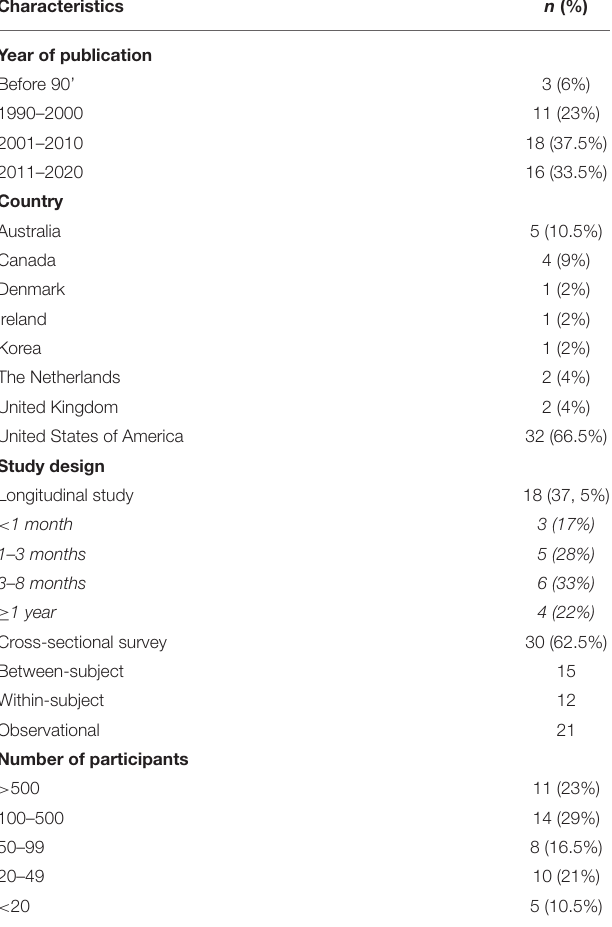
TABLE 1 | Characteristics of the systematic literature review